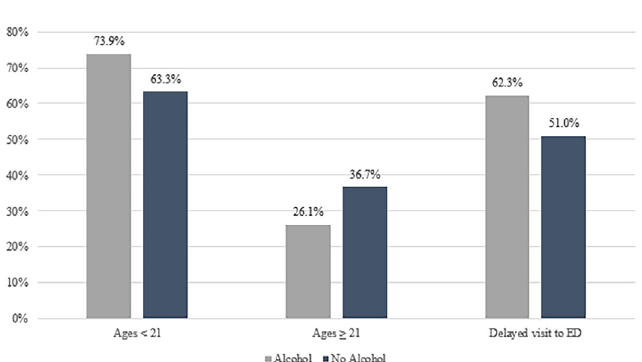
Figure 2. Percentage of sexual assault cases with reported alcohol use by age group among emerging adults.